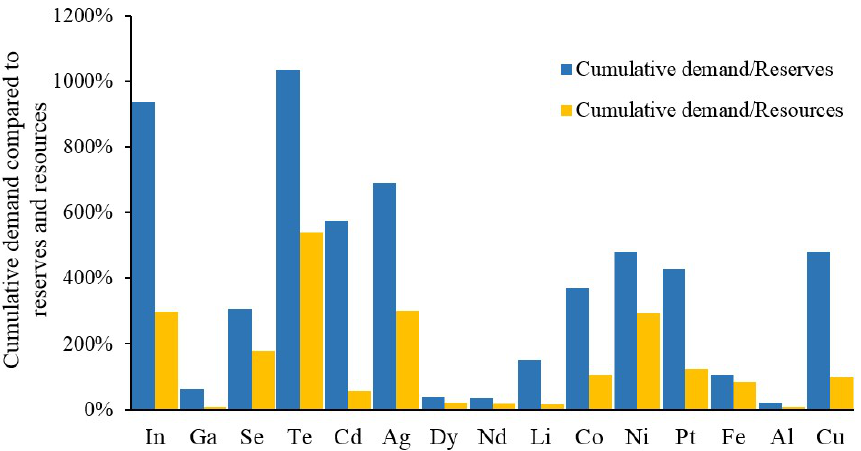
Figure 13. Cumulative demand from 2016 to 2060 compared to the reserves and resources in the case of 2DS-Ref. Minerals 2018 , 8 , x FOR PEER REVIEW